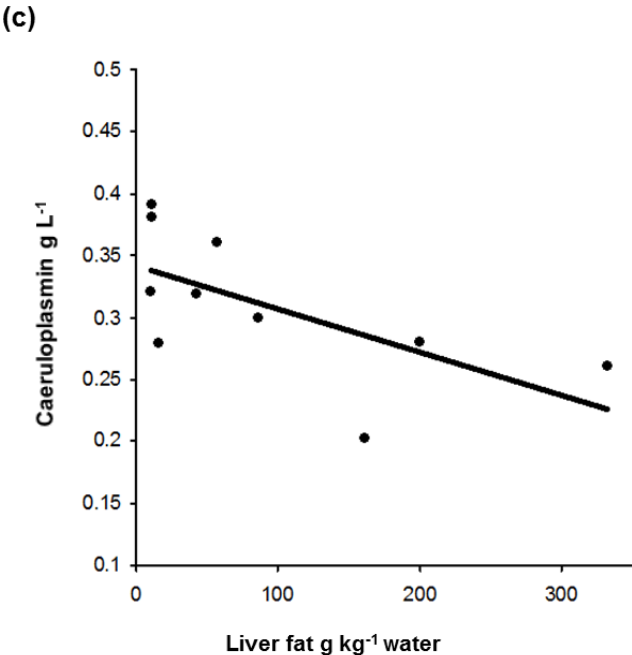
Figure 2. Relationship of insulin ( a ); glycerol ( b ); and caeruloplasmin ( c ) with liver fat